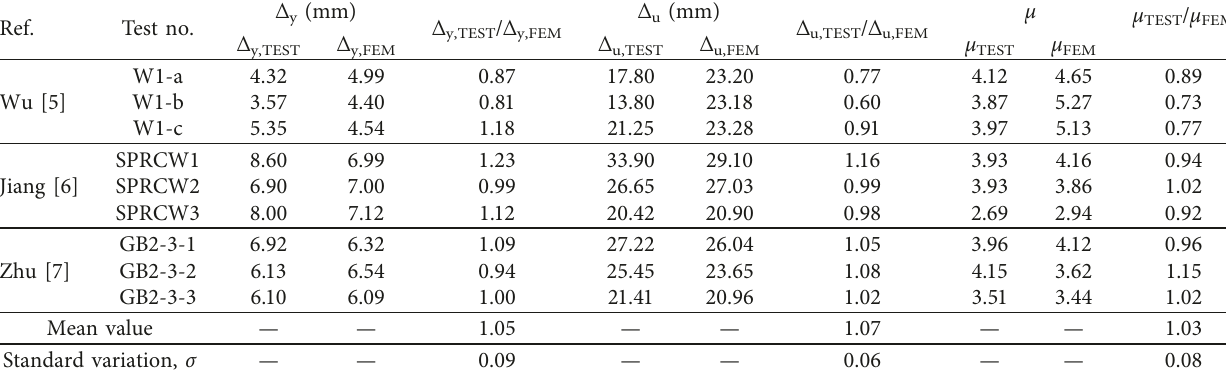
Table 3: Comparison of deformation capacity between tests and finite element results.